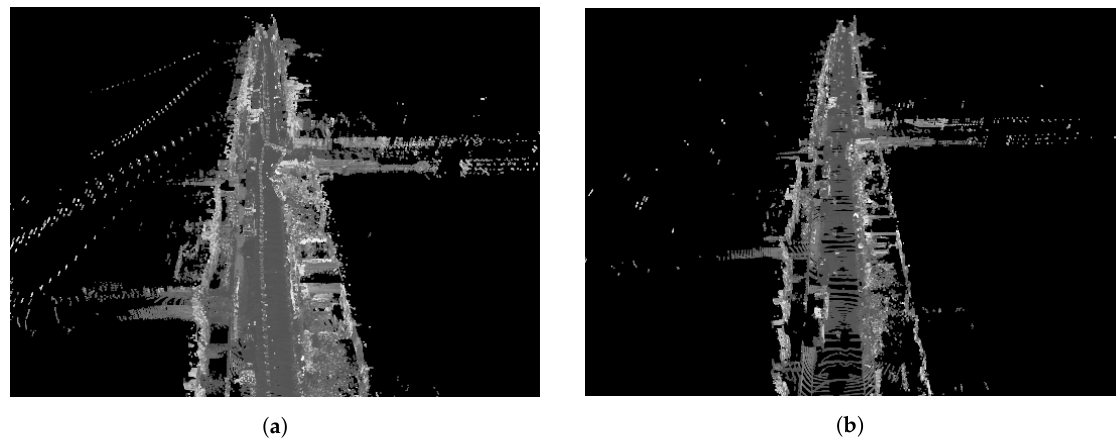
Figure 3. A comparison of the accumulated point clouds ( a ) before and ( b ) after spatial downsampling as described in Section 3.1.2. Basically, a new LiDAR scan is added to the accumulated dense point cloud every time the vehicle moves 10m from its last location. As a result, a sparser and less erroneous point cloud is produced. This step is primarily aimed at mitigating extreme density of points for calculating traversability (c.f. Section 3.2) while still maintaining the extended LiDAR sensing horizon (out to the radar horizon) as per Section 3.1.1.